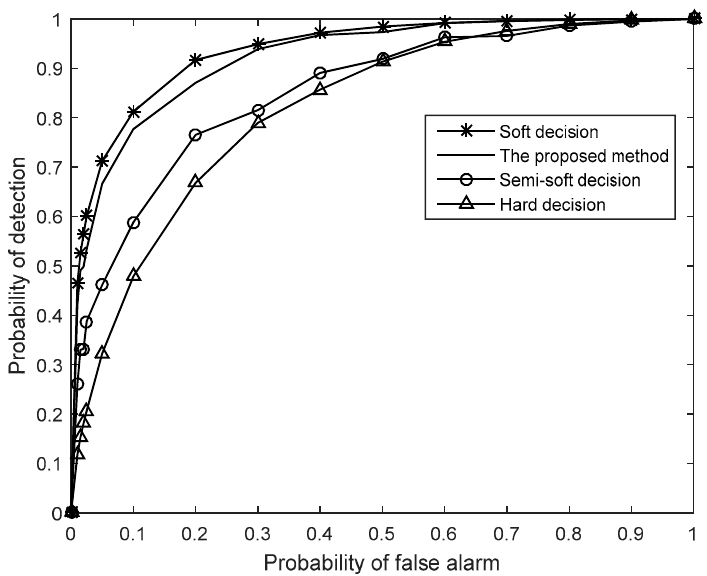
Figure 5. Comparisons of the receiver operating characteristic (ROC) curves ( M = 10, N = 1000, SNR = − 15 dB).